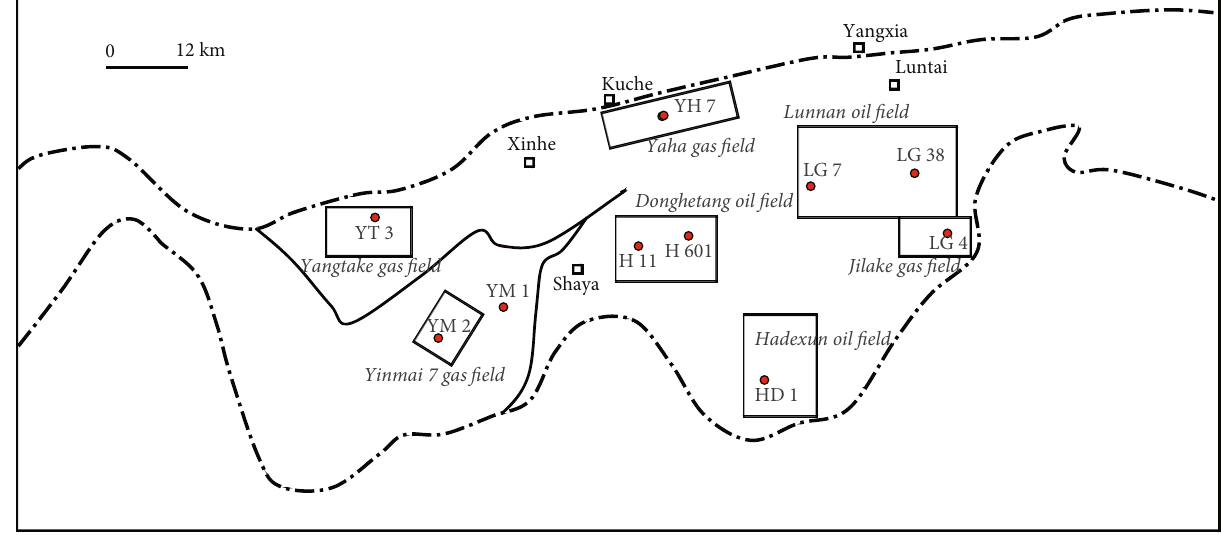
Figure 1: The structural location map of Yingmai 7 block